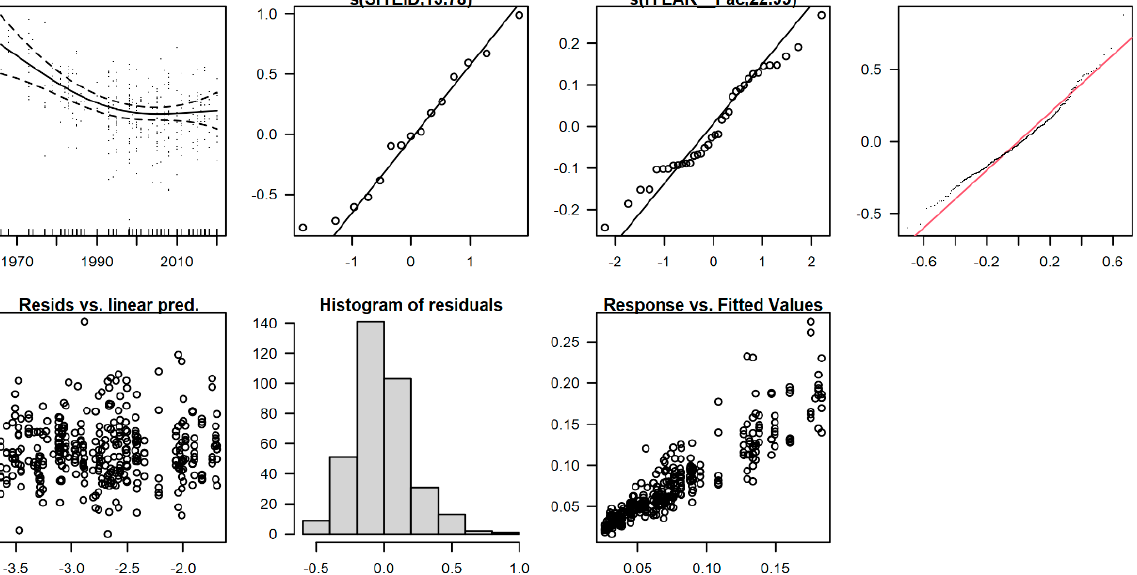
Figure A3. Example of graphical residual analysis (normality; homogeneity) of the selected gener- alized additive mixed model (GAMM) for pH(H 2 O) values at unlimed plots in a 0–30 cm soil depth.